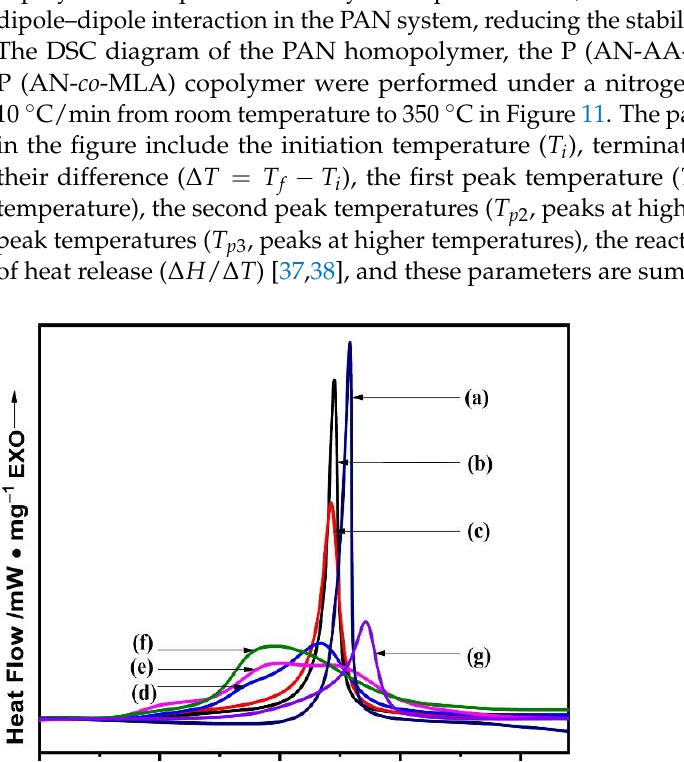
Figure 10. XRD patterns of P (AN- co -MLA) copolymers with mass feed ratio of AN/MLA = 97/3 (wt/wt) at various temperatures for 30 min.